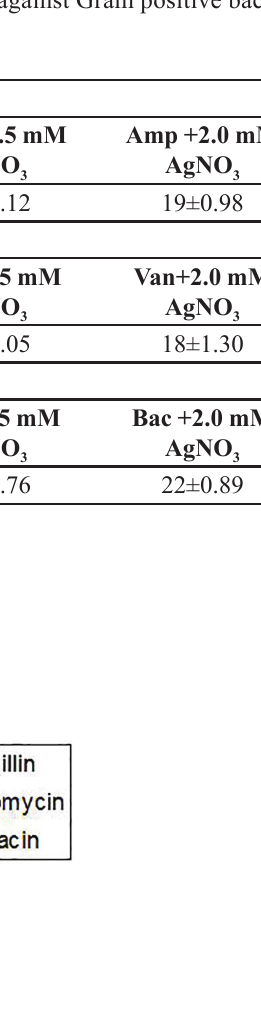
FIGURE 6 - Zone of inhibition (in mm) for different antibiotics (ampicillin, vancomycin and bacitracin) at different concentrations of AgNO (0.5, 1, 1.5 and 2 3